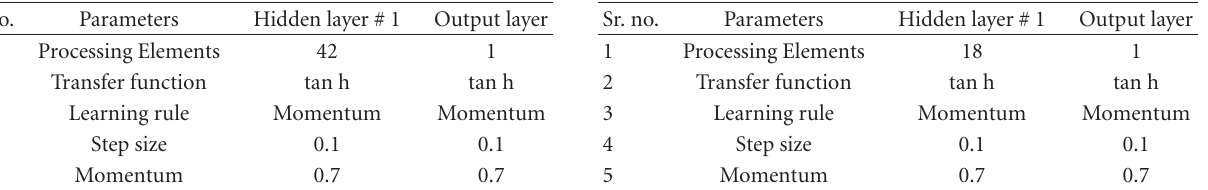
Table 2: Parameters of Fully Recurrent NN (Lab. data). Number of Exemplars: Training = 306, Testing = 77, Max epoh = 1000, memory-axon, Norm → L1.